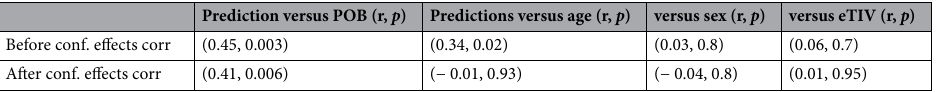
Table 2. Predictions with and without confounding